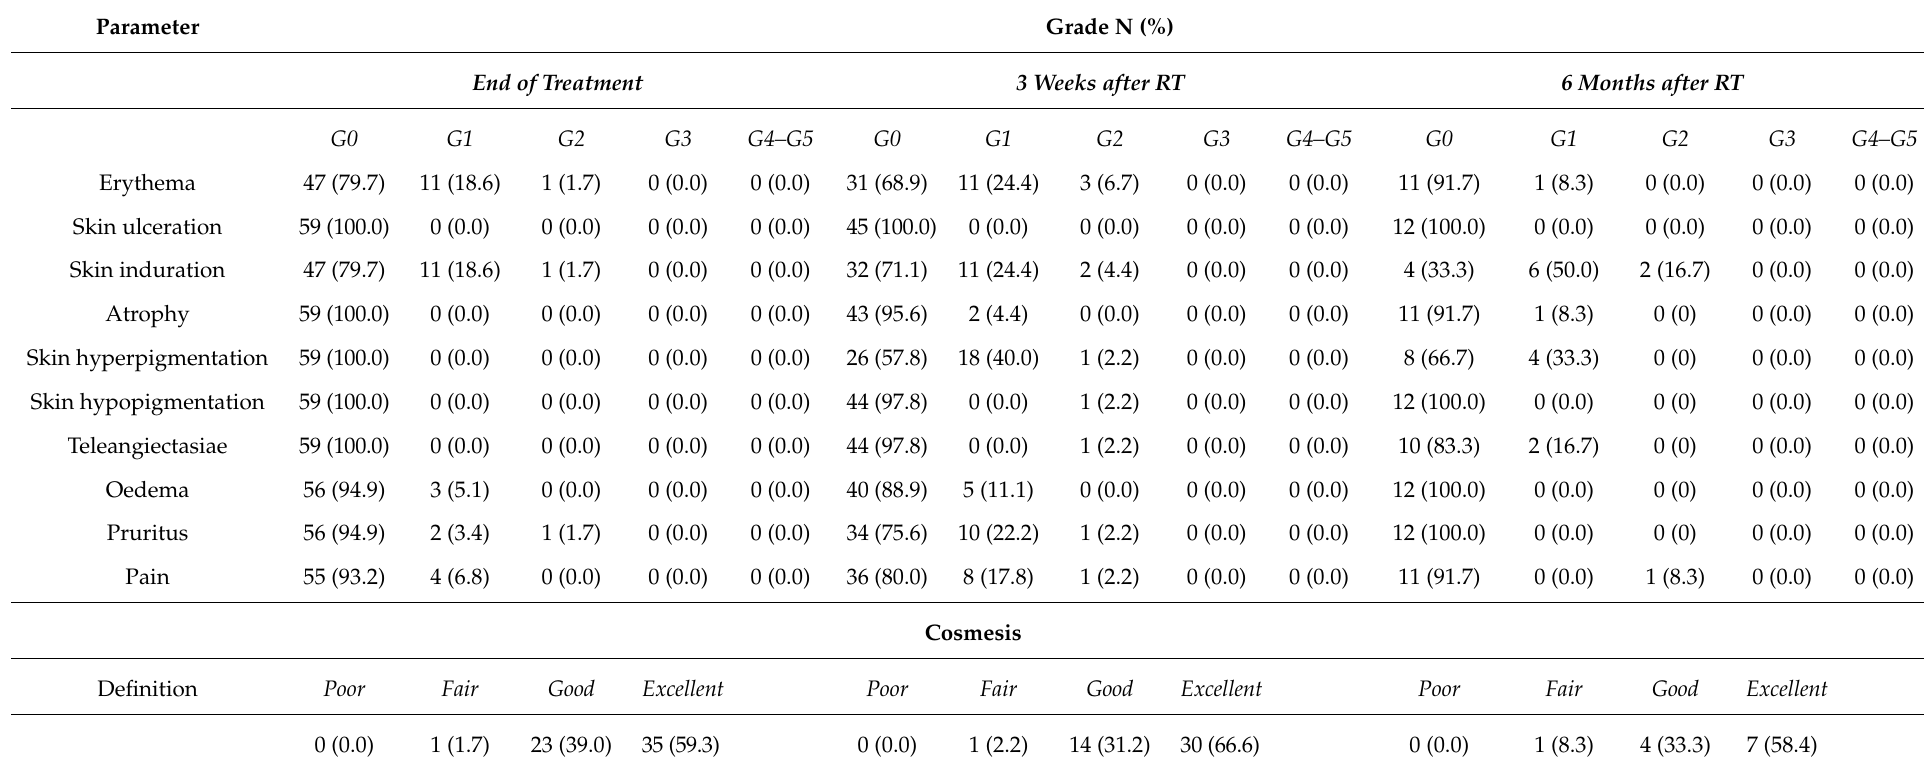
Table 5. Toxicity profile and cosmesis for the 26 Gy in 5 fractions over 1 week